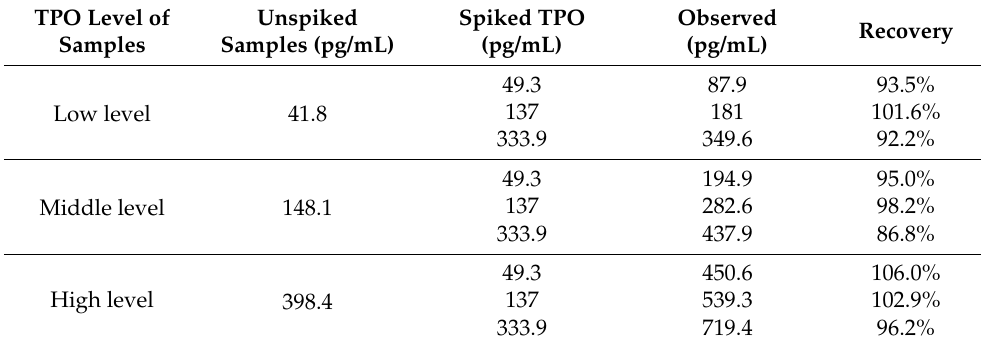
Table 3. Recovery of TPO spiked into plasma samples.